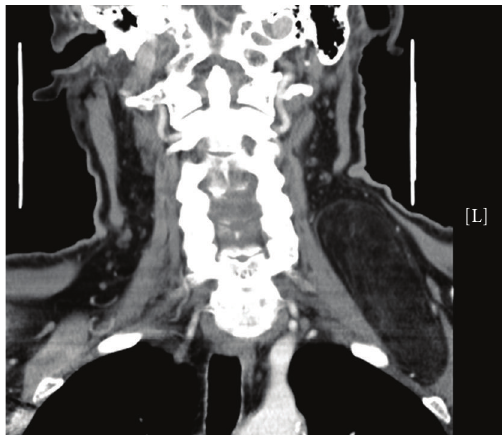
Figure 1: Coronal CT scan of the neck showing a left supraclavicu- lar mass with internal septations.